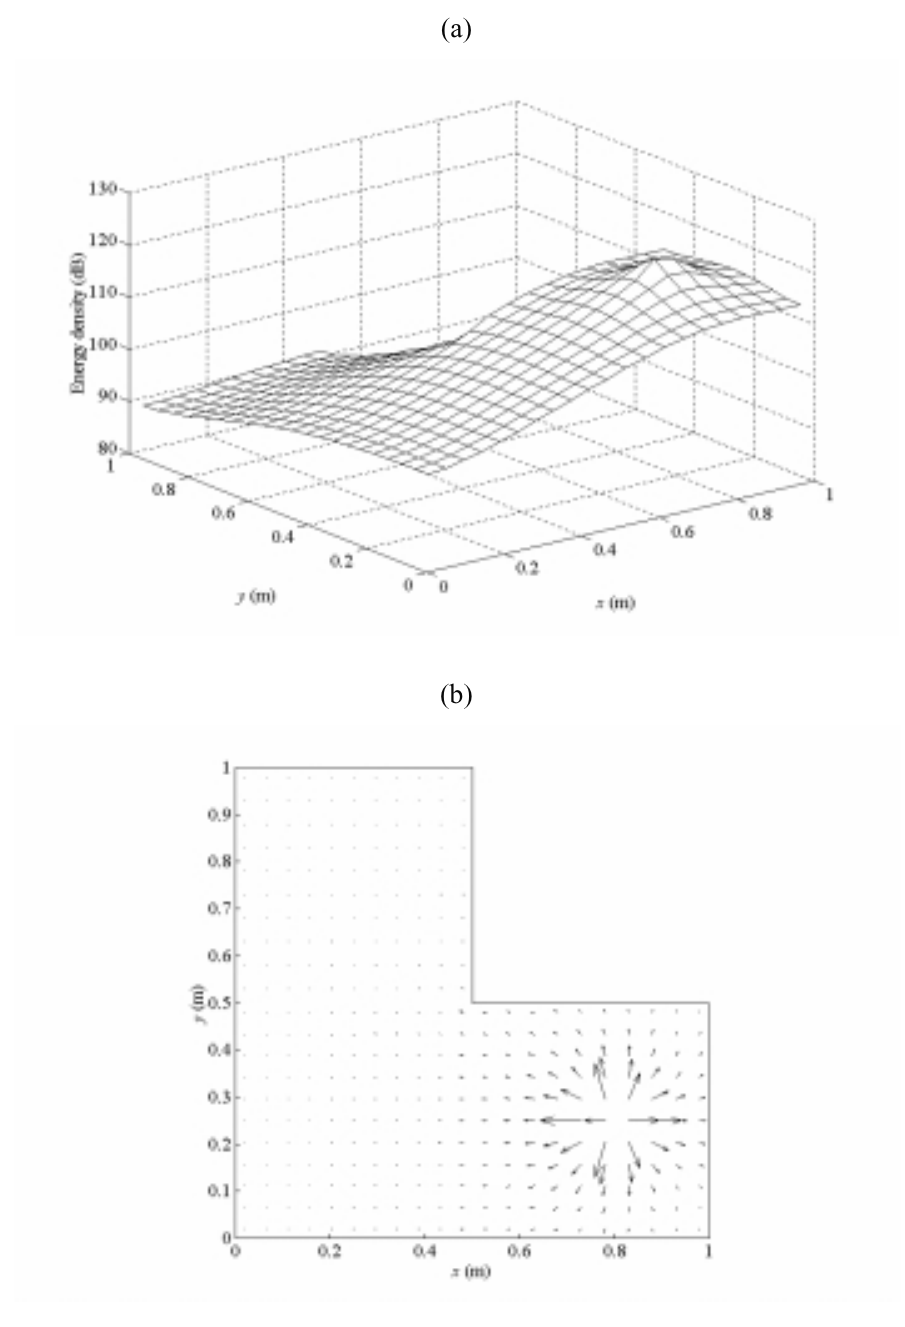
Fig. 13. The energy density and intensity distributions in L-shaped plate predicted by direct EFBEM when f = 1 kHz and η = 0 . 2 . The reference energy density is 1 × 10 − 12 J/m 2 ; (a) energy density, (b) intensity. direct and indirect method are performed. The developed energy integral equations are discretized and applied to predict the energy density and intensity distributions of a simple beam and a thin plate. From numerical examples of the beam and plate, it has been confirmed that the approximate energy density and intensity field obtained by energy flow boundary element analysis well represent the global variation of the